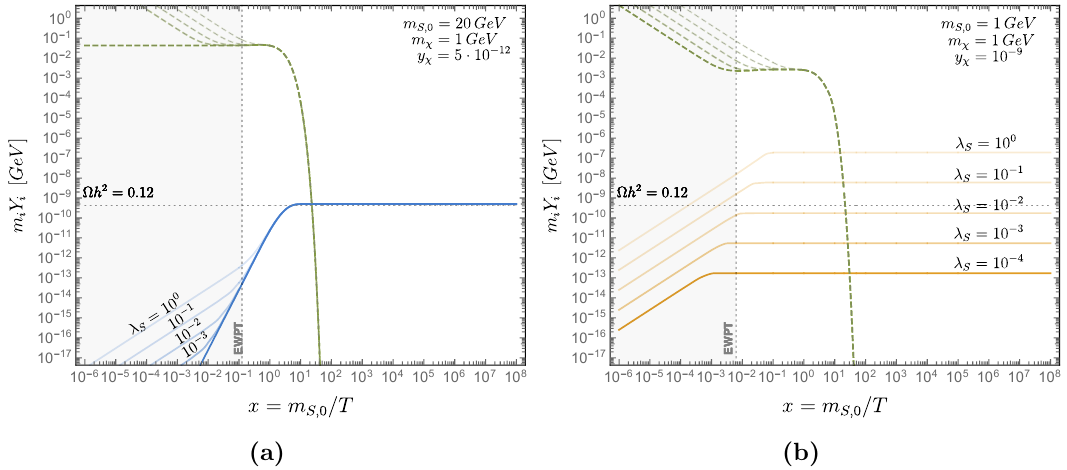
Figure 5. Typical evolution of the yields of S (dashed green) and (cid:31) (solid). The lower the line opacity the larger the self-coupling (cid:21) . (a) A standard freeze-in case where the impact of (cid:21) S the yields is only important at very high T when there is not enough time to produce signi(cid:12)cant amounts of (cid:31) particles, leading to approximately the same value of their (cid:12)nal relic abundance. (b) A forbidden freeze-in case where the thermal mass of S has the dominant e(cid:11)ect that opens